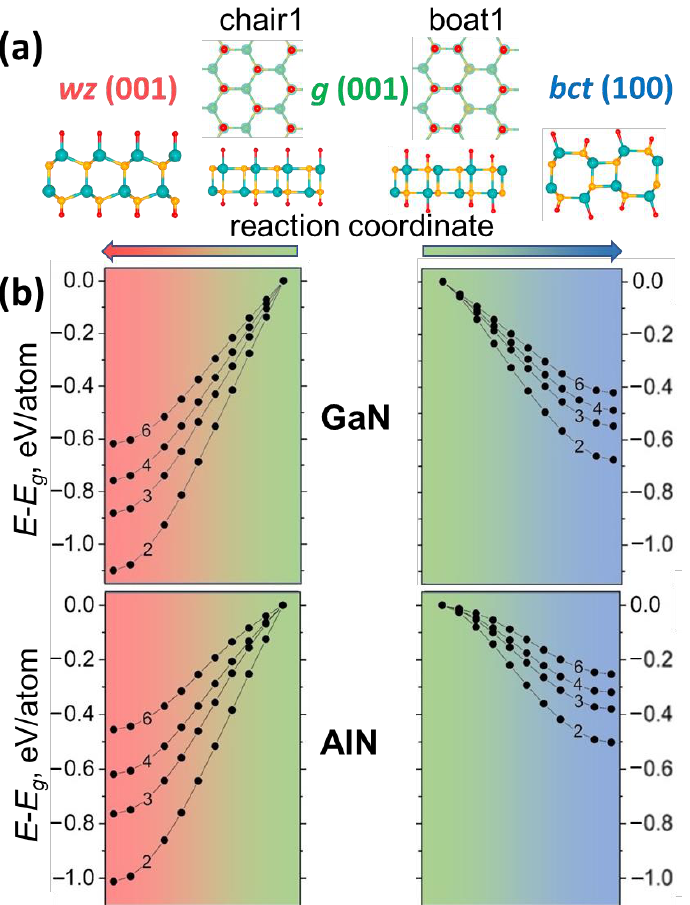
Figure 3. ( a ) Top and side view of GaN and AlN graphene-like films with hydrogen in position “ chair1 ” and “ boat1 ” . These films transform into wz (001) or bct (100) (side view is shown) depending on the arrangement of H atoms. ( b ) The transformation barriers of the g-GaN and g-AlN thin films with hydrogenated surface to the bct and wurtzite phase. The energy of the hydrogenated graphene-like film is taken as zero.